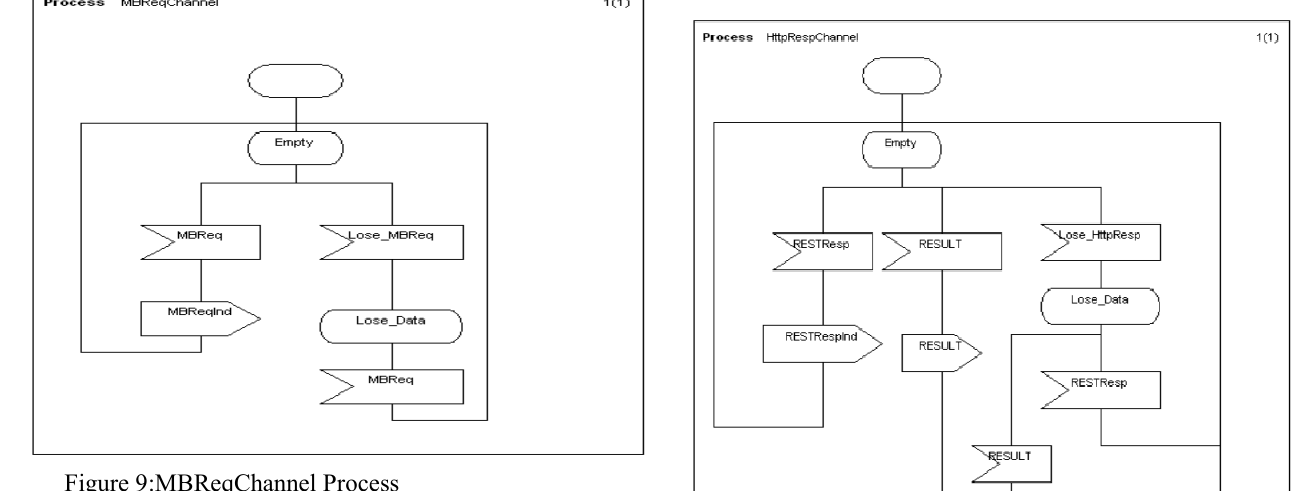
Figure 9:MBReqChannel Process